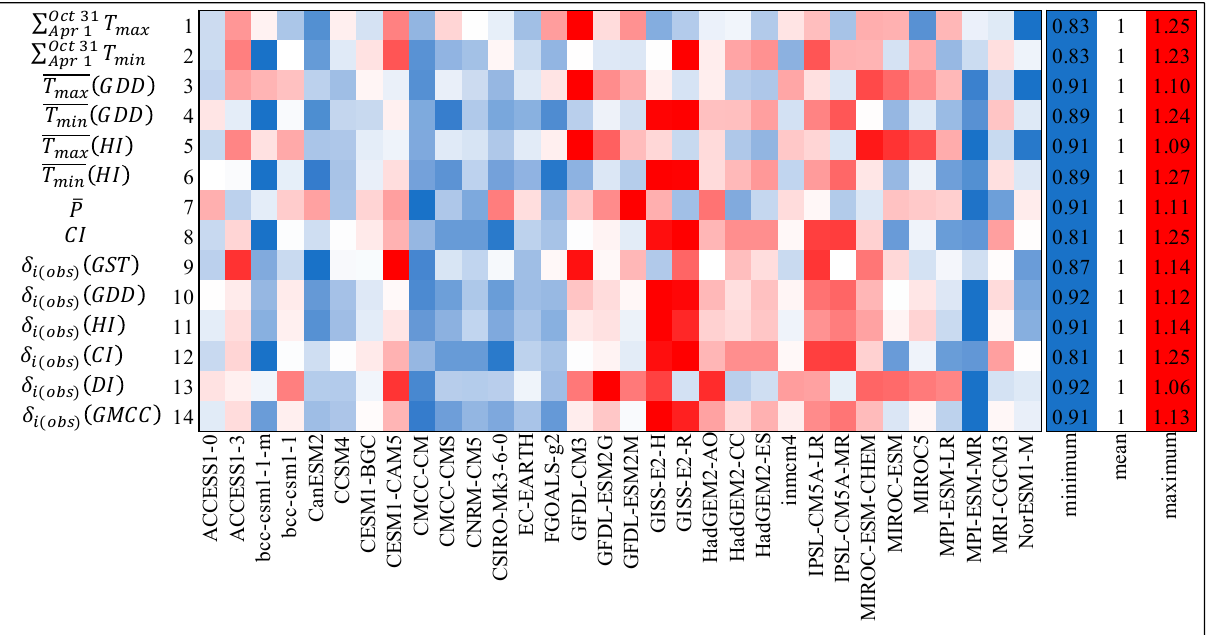
Figure 2. A graphical representation of calculated viticulture climate classification specific (i.e., growing season average temperature (GST), growing degree days (GDD), Huglin index (HI), cool night index (CI), dryness index (DI), and the Géoviticulture multicriteria climate classification (GMCC)) Localized Constructed Analogs (LOCA) Coupled Model Intercomparison Project phase 5 (CMIP5) [40,41] model relative root mean squared error (RMSE) and normalized median skill values for the Willamette Valley American Viticultural Area during the LOCA CMIP5 defined historic period (1950–2005). The color scale is shown for each row, and blues/reds represent models with more/less skill than the ensemble mean (white).